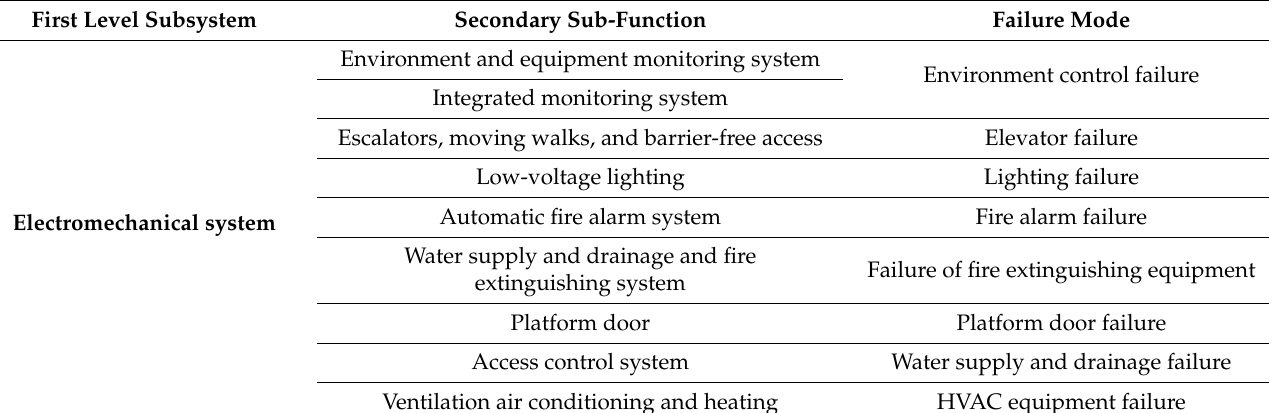
Table 3. The failure mode analysis results of the electromechanical